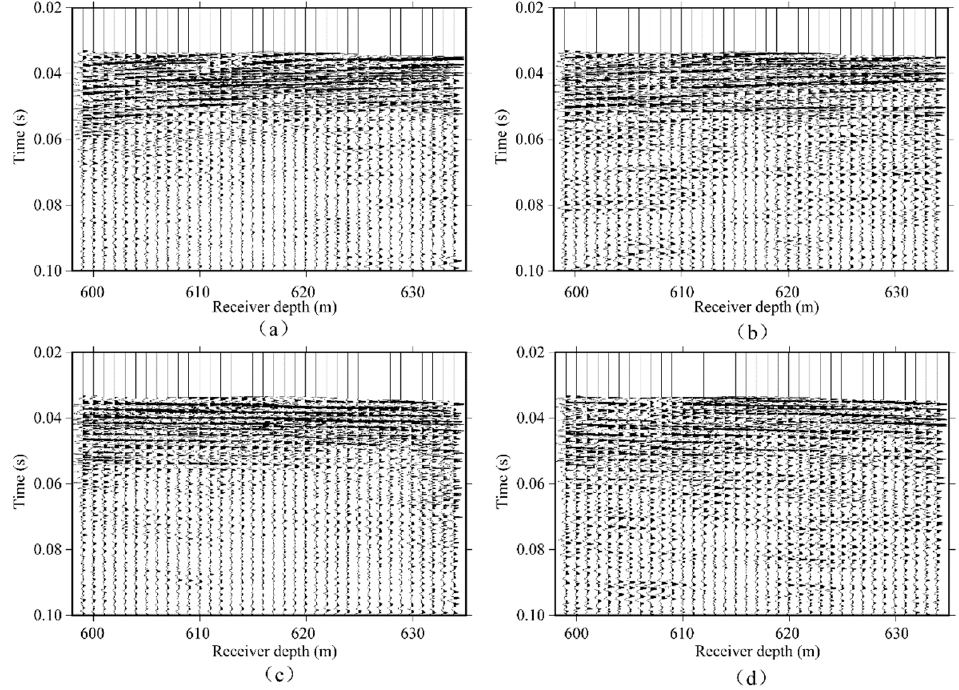
Figure 15. ( a ) An example shot gather from the baseline survey. ( b ) The corresponding shot gather from the second-repeat survey. Table 1. Processing steps used in the real time-lapse cross-well datasets.